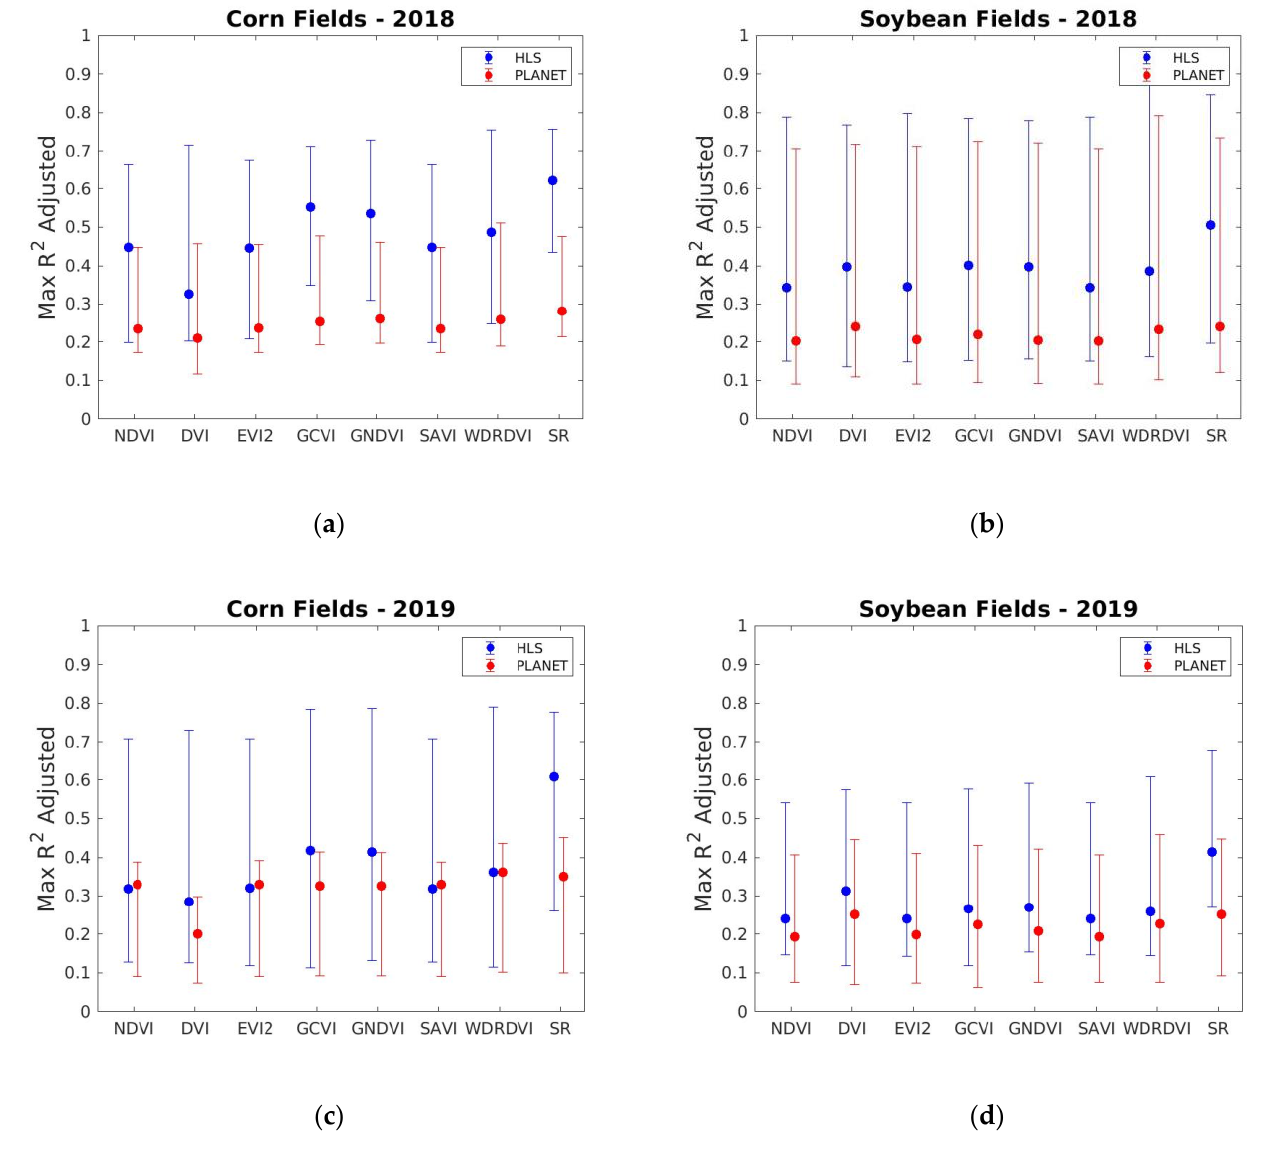
Figure 10. Median along with 10th and 90th percentile values of the maximum of coefficient of determination 𝑅 adj2 for various HLS- and Planet-derived features: ( a )–( c ) for corn and ( b )–( d ) for soybean.